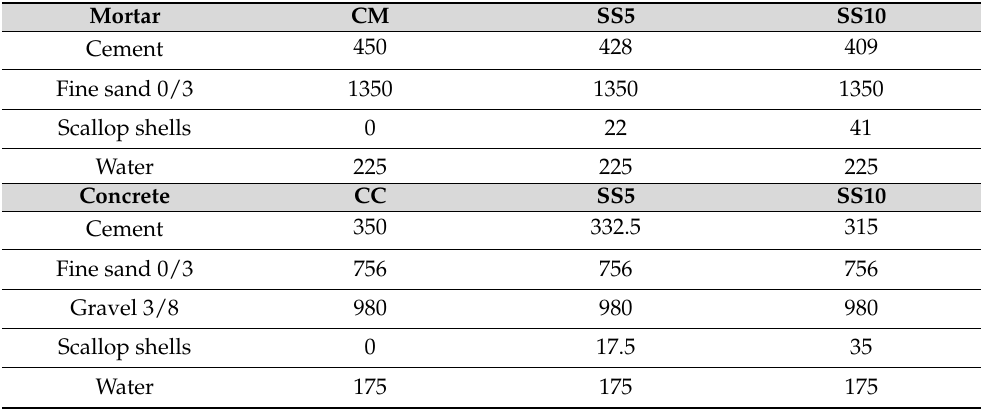
Table 2. Composition of the different mortar and concrete mixes (Kg · m − 3